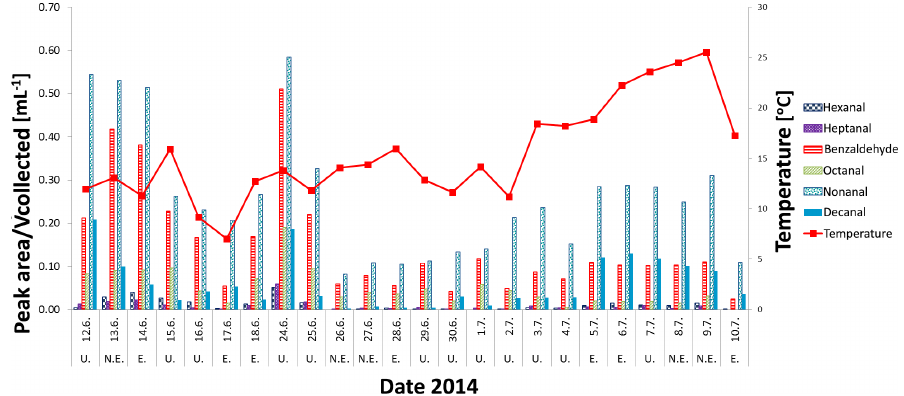
Figure 2. Daily average amounts (peak areas/Vcollected) of aldehydes collected by NTME and analysed by portable GC–MS in mid-summer 2014 (E. corresponds to a day when a nucleation event was observed, U. to an undefined event and N.E. to a day without nucleation